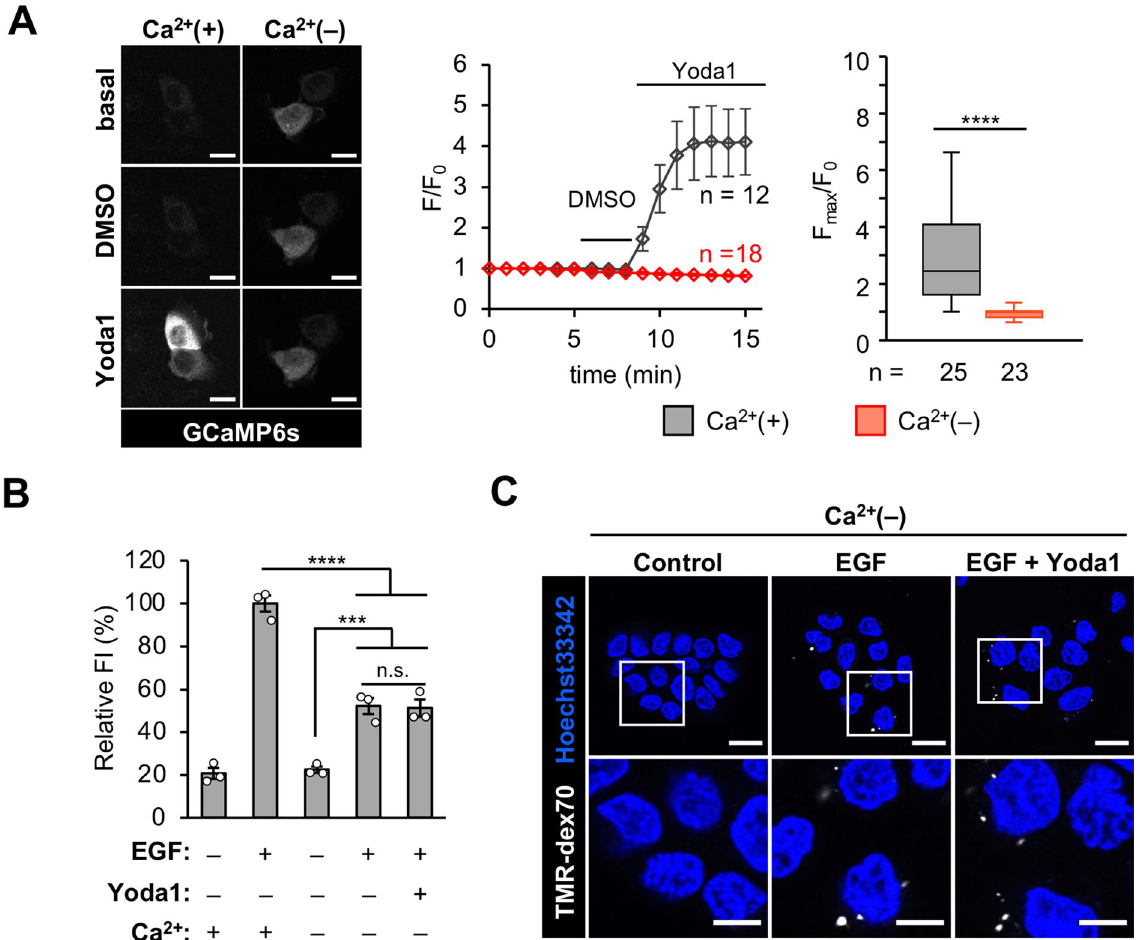
Figure 4. Macropinocytosis inhibition by Yoda1 requires extracellular Ca 2+ influx. ( A ) GCaMP6s fluorescence intensity was recorded every 1 min. DMSO and Yoda1 (1.5 µM) were added at 5 and 8 min after start of time- lapse imaging, respectively. Left: Representative images of the GCaMP6s-expressing cells treated DMSO and Yoda1 in the absence or presence of Ca 2+ in culture media. Middle: Representative time-course of relative fluorescence intensity of GCaMP6s. Data represent the mean ± s.e.m. (n = 12 and 18 cells for Ca 2+ (+) and Ca 2+ (−), respectively). Right: Quantification of maximum Yoda1-induced GCaMP6s intensity increase. Data represent in box plot (n = 25 and 23 cells, for Ca 2+ (+) and Ca 2+ (−), respectively, pooled from two independent experiments). Box and whiskers graph: line, median; box, upper and lower quartiles; whiskers, maxima and minima. ( B ) Flow cytometry analysis of EGF-stimulated TMR-dex70 uptake in Ca 2+ -containing or Ca 2+ -free condition in the absence or presence of Yoda1 (1.5 µM). Data represent the mean ± s.e.m. (n = 3 independent biological replicates). ( C ) Observation of TMR-dex70 uptake in Ca 2+ -free condition. The cells were treated as ( B ). The bottom images show enlarged views of the areas outlined by the white squares in the top images. ***p < 0.001; ****p < 0.0001; n.s. not significant [Student’s t test ( A ) or one-way ANOVA followed by Tukey– Kramer’s post hoc test ( B )]. Scale bars, ( A , C , top) 20 µm; ( C , bottom) 10